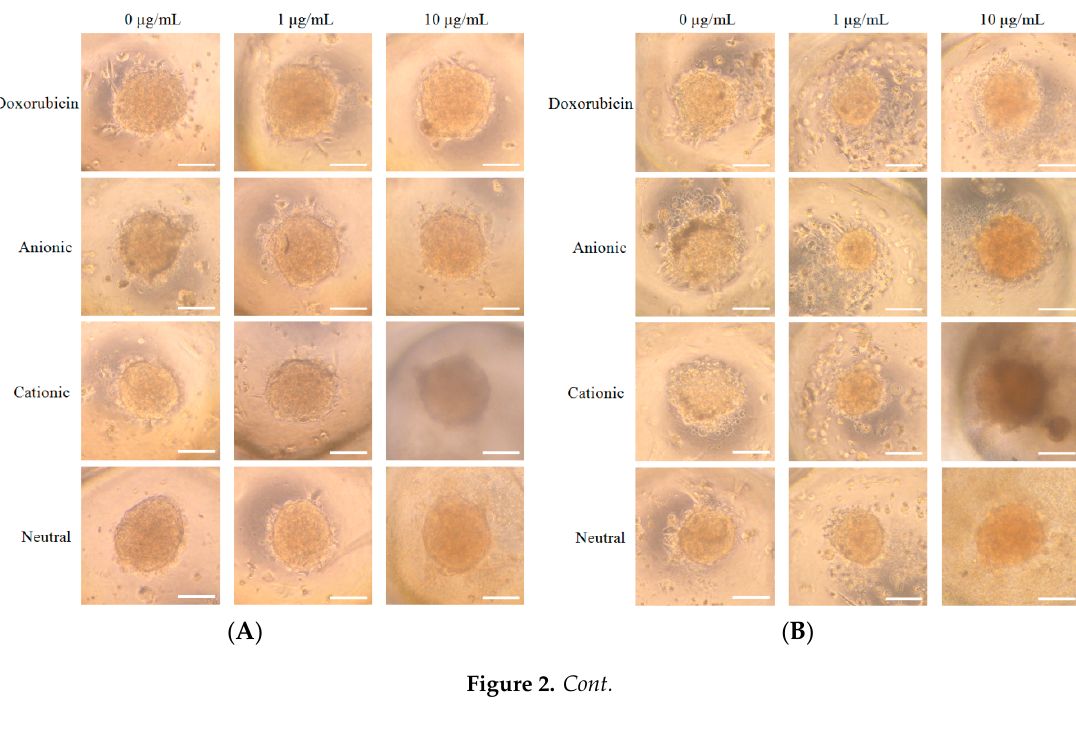
( D ) Figure 2. ( A ) Morphology of the cell spheroids cultured in osteogenic media on Day 1 (original magnification ×200). The scale bar indicates 100 μ m. ( B ) . Morphology of the cell spheroids cultured in osteogenic media on Day 3 (original magnification ×200). The scale bar indicates 100 μ m. ( C ) Morphology of the cell spheroids cultured in osteogenic media on Day 5 (original magnification ×200). The scale bar indicates 100 μ m. ( D ) Morphology of the cell spheroids cultured in osteogenic media on Day 7 (original magnification ×200). The scale bar indicates 100 μ m. Table 1. The cellular viability of stem cell spheroids on Days 1, 3, 5, and 7. Day